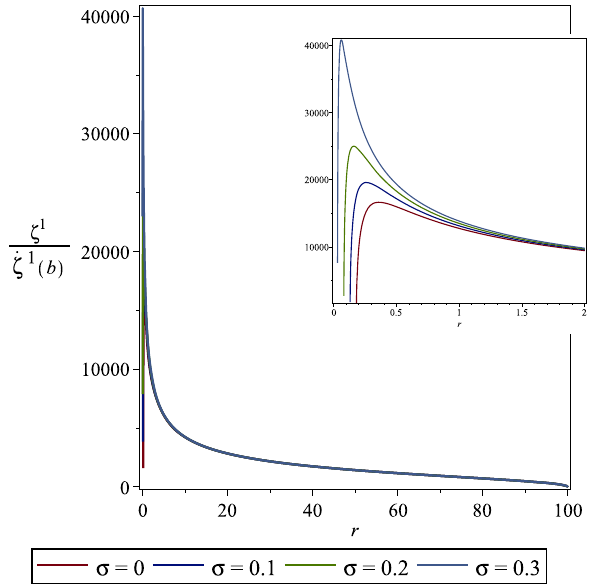
Fig. 7 Radial components of geodesic deviation for a Kiselev BH surrounded by radiation with IC2 for different values of the radiation parameter with M = 1, q = 0 . 6 and b = 100